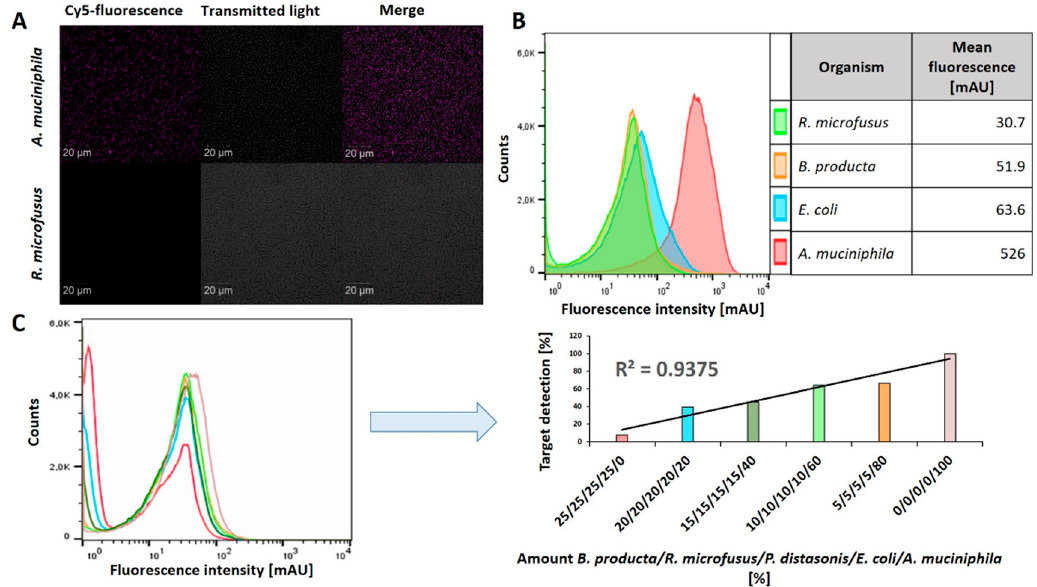
Figure 5. Akk13.1 is suitable for application in modern bioanalytical techniques. ( A ) Confocal laser scanning microscopy of aptamer labeled A. muciniphila cells. The fluorescent labeled aptamer Akk13.1 was sufficient to label Akkermansia cells. R. microfusus served as a control and did not display any colocalization of the aptamer with the cells. ( B ) Specific identification of A. muciniphila by flow cytometry analyses. A. muciniphila , R. microfusus , A. stercoricanis , E. coli were incubated with the aptamer and analyzed by flow cytometry measurements. The mean fluorescence of A. muciniphila is 8- to 17-fold higher in comparison to the other organism. ( C ) Identification of A. muciniphila contaminated with the microbiome associated organisms B. producta , R. microfusus , P. distasonis and E. coli . The fluorescence signal correlates with the increasing amount of A. muciniphila in the mixture.